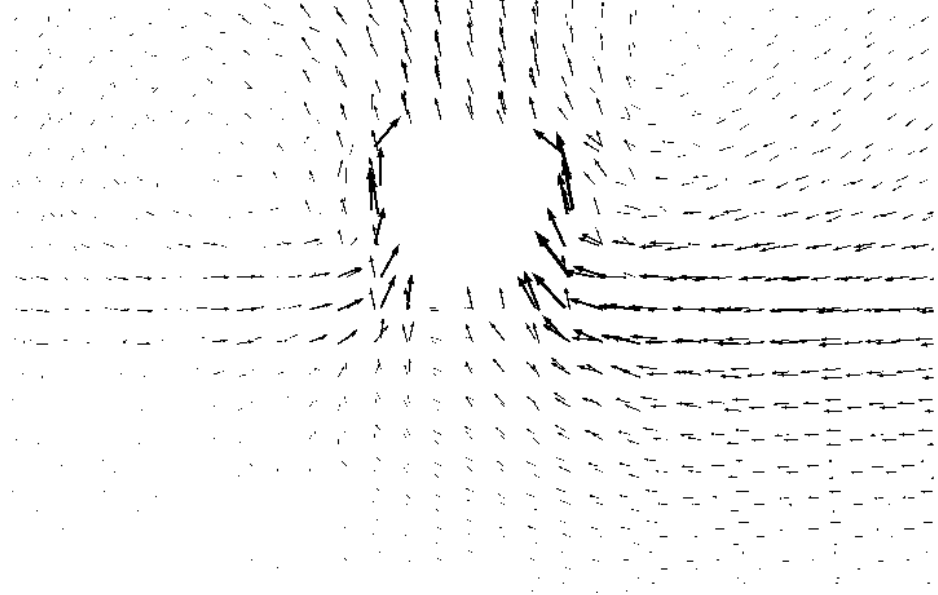
Figure 22. Displacement vector diagram of soil around tunnel structure.